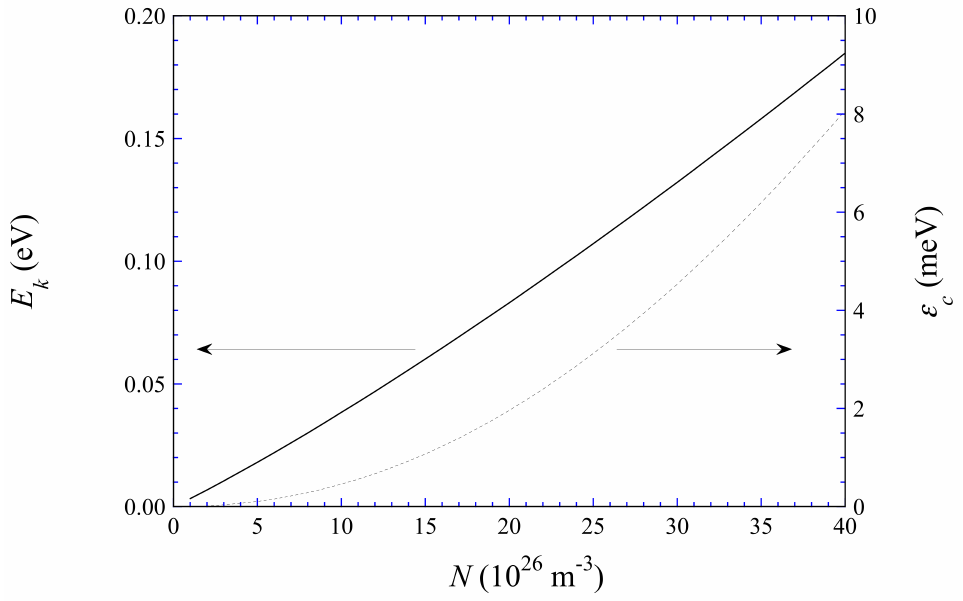
Figure A1. The density dependence of the energy shift E k (left scale) and of the mobility edge energy e c (right scale).